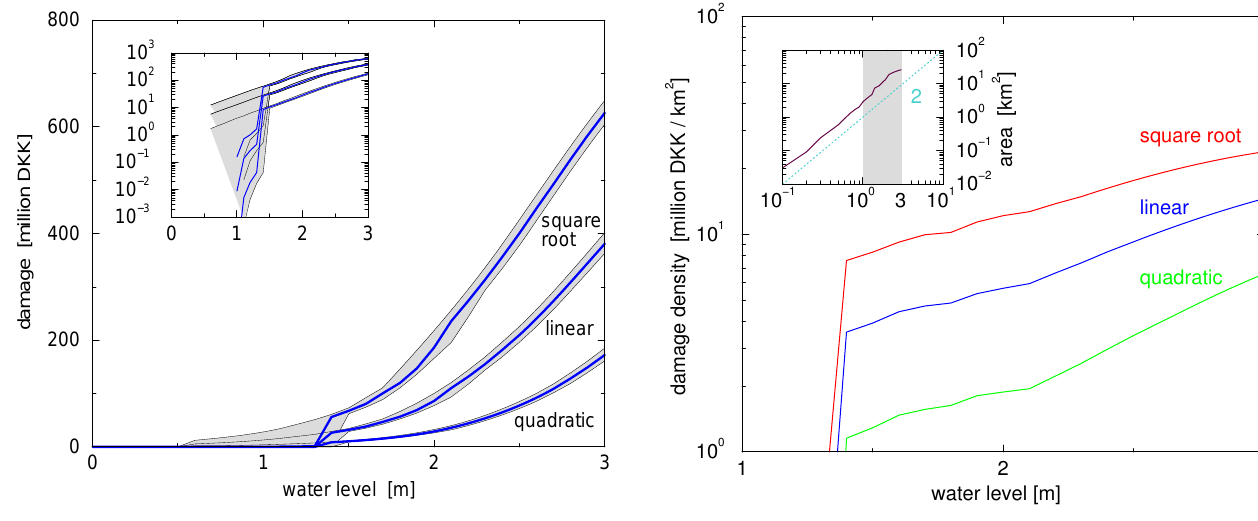
Fig. 7. Damage density and inundated area vs. water level. The damage density, defined as damage per area, is plotted as a function of the water level for the non-coarse-grained mode with 4 nearest neighbours. We assume square root, linear, or quadratic building damage functions (from top), Eqs. (1), (3), and (4), see Fig. 2. The inset shows the inundated area as a function of the water level. The dotted line is a guide to the eye and follows a power-law with expo- nent 2. The grey area indicates the range of water levels shown in the main